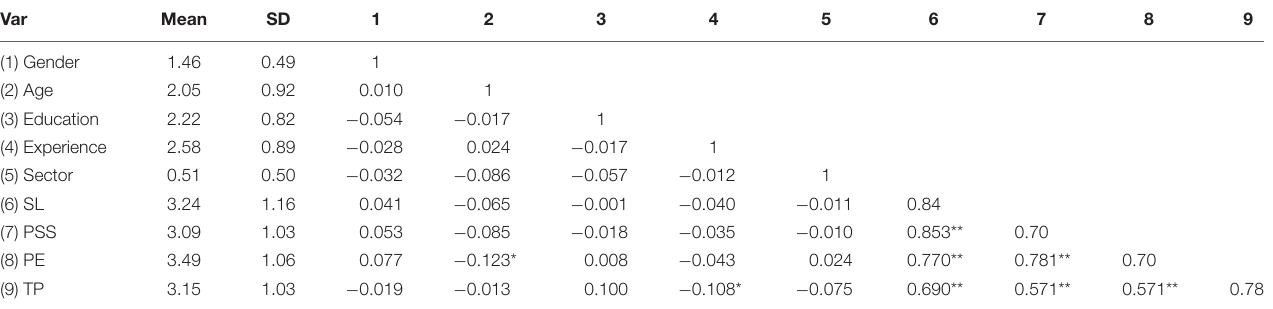
TABLE 2 | Mean, standard deviation, and correlation results.